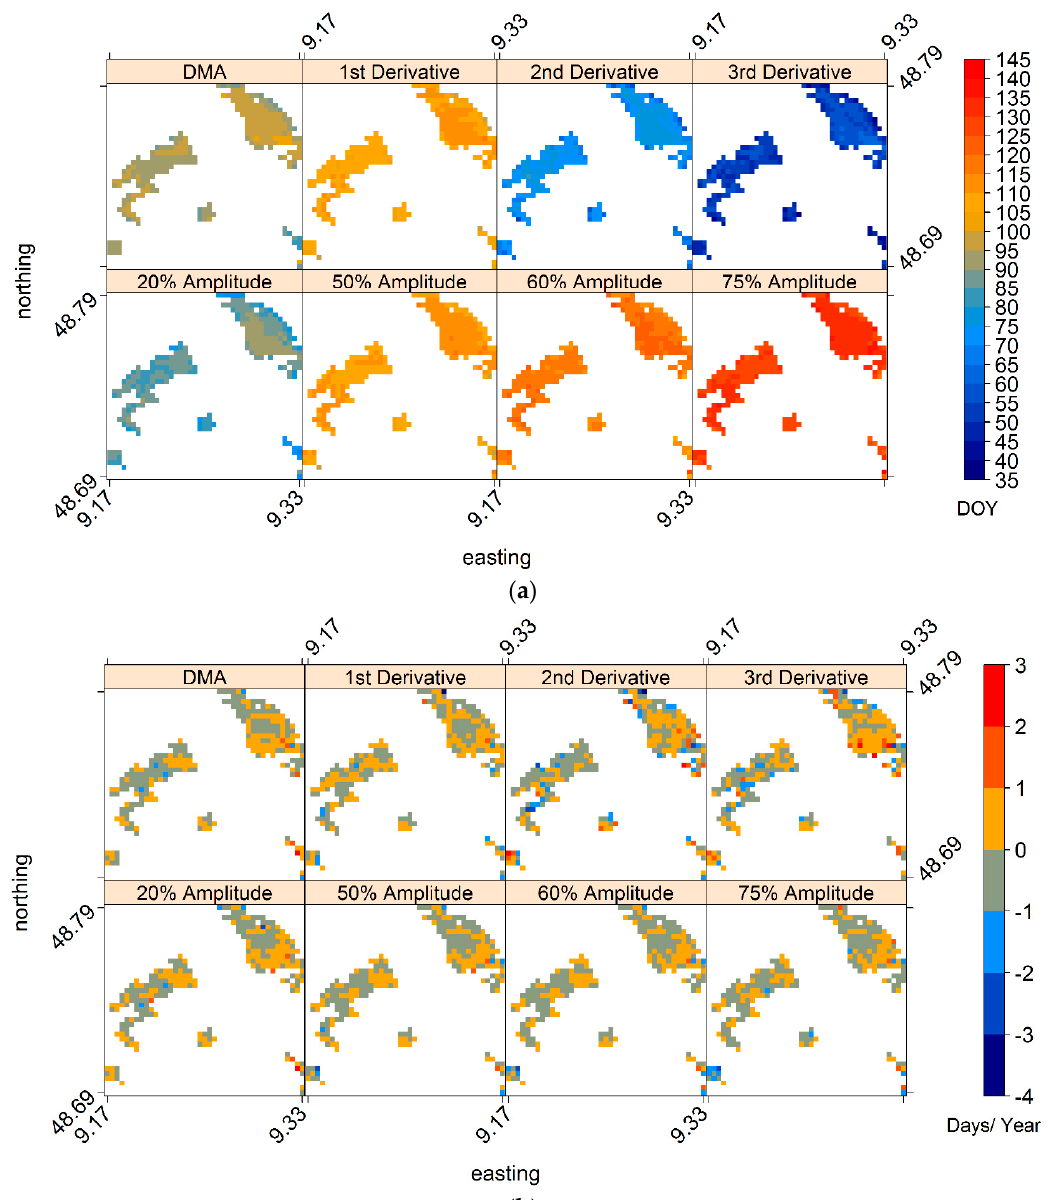
Figure 4. ( a ) Mean LSP-SOS (day of year) for the broadleaf pixels in the study area; ( b ) Linear trends of LSP-SOS (days/year) for the broadleaf pixels in the study area.